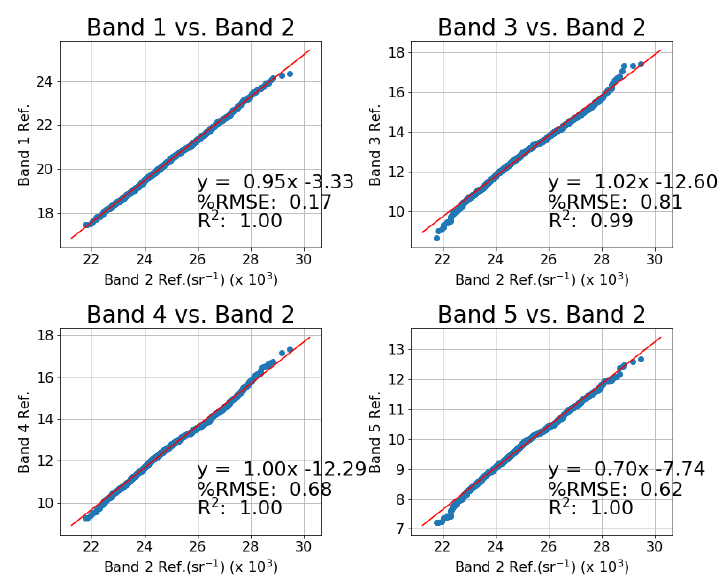
Figure 8. The QQ plots of water reflectance for the four spectral bands, with respect to Band 2 and the corresponding regression results.